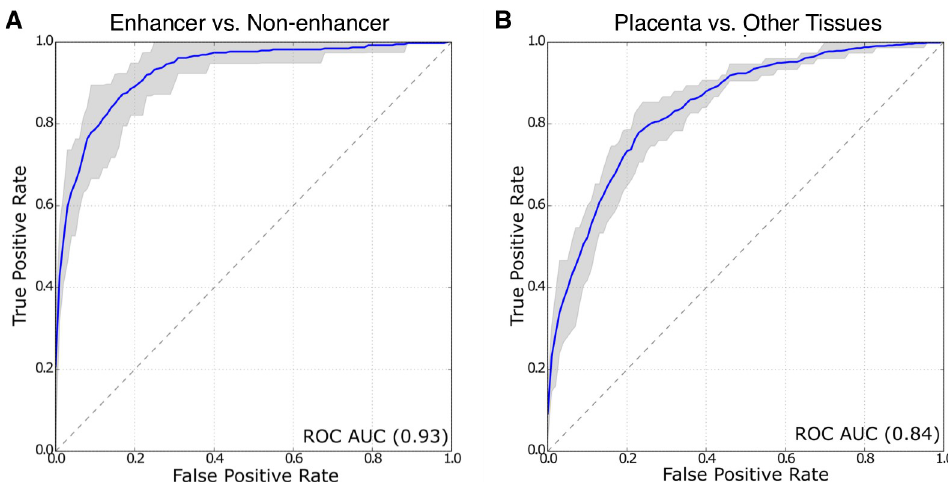
Fig 2. The trained classifiers accurately identify placental enhancers. (A) Receiver operating characteristic (ROC) curves for the classifiers trained to distinguish enhancers from non-enhancers (Step 1) and (B) placental enhancers from enhancers active in other tissues (Step 2). Both perform significantly better than expected by chance with areas under the ROC curve (AUC) of 0.93 and 0.84 respectively. The shaded region represents the performance range observed over the 10 cross validation runs. The diagonal line represents chance performance. The corresponding Precision-Recall curve AUCs are 0.78 and 0.70, respectively (S1